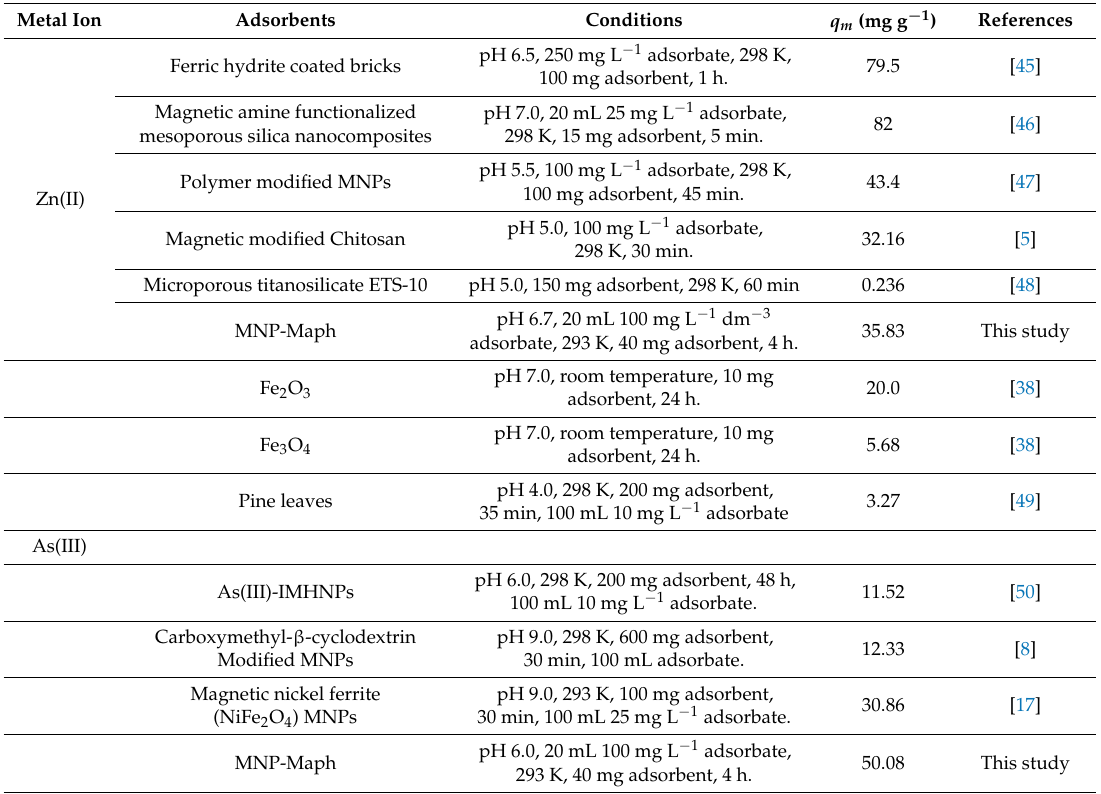
Table 6. Langmuir maximum adsorption capacity, q m for Zn(II) and As(III) uptake from aqueous solutions by MNP-Maph and other magnetic nanoparticles previously